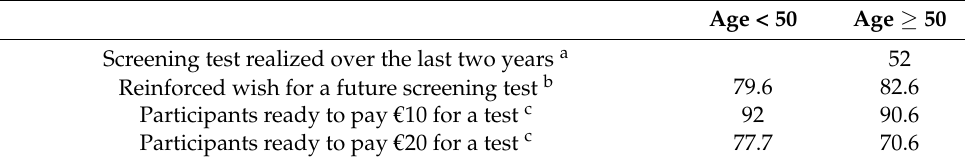
Table 5. Adhesion to colorectal cancer screening: % of “yes” answers among